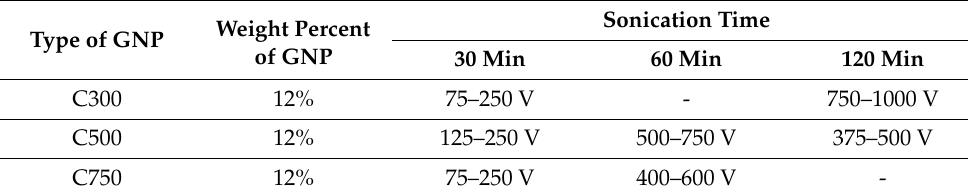
Table 1. Joule effect ignition voltage for all epoxy-GnP systems. This voltage is tied to the most effective specimen within the three analysed for each system configuration. The ranges shown collect all the activation voltages of the specimens analysed for each system configuration with heating